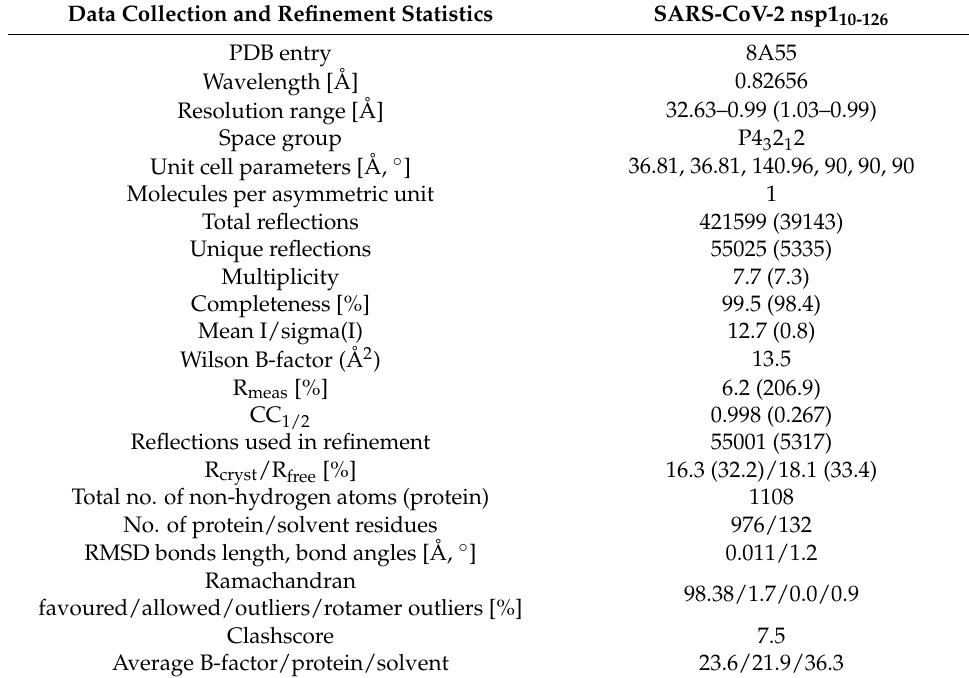
Table 1. Data collection, structure determination and refinement statistics for SARS-CoV-2 nsp1 10-126 . Data in parenthesis correspond to the highest resolution